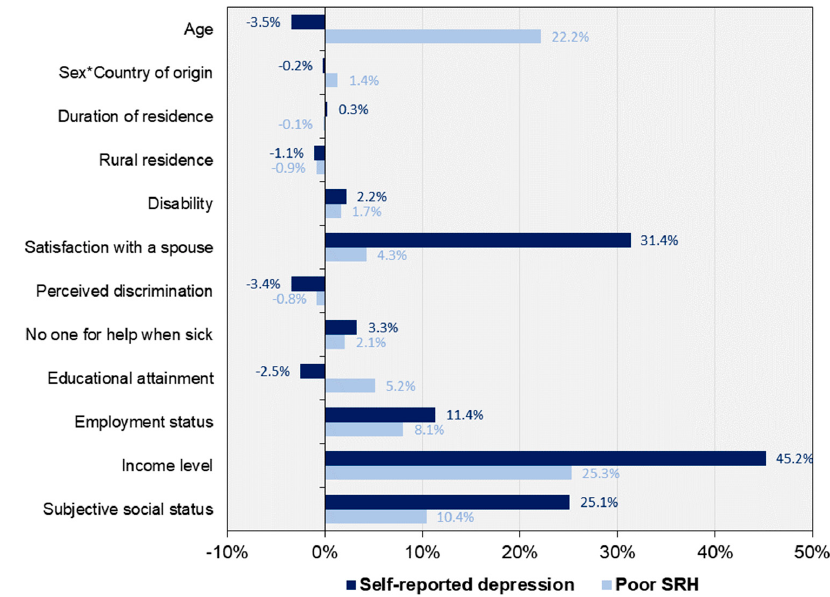
Figure 2. Contribution (%) of each determinant to the total income-related inequality in self-reported depression and poor SRH. Note: This graph describes contribution (%) of each socio-demographic determinant to the concentration index for self-reported depression and poor SRH, respectively.